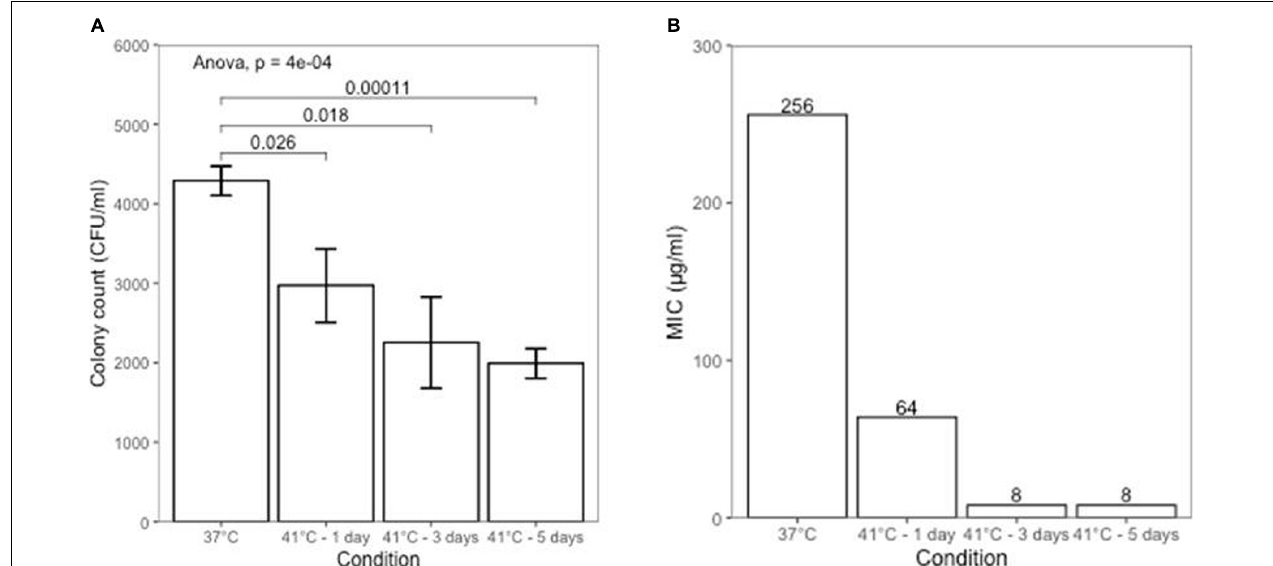
FIGURE 1 | (A) Growth inhibition of H. pylori at different temperature conditions. (B) Changes in metronidazole susceptibility at different temperature